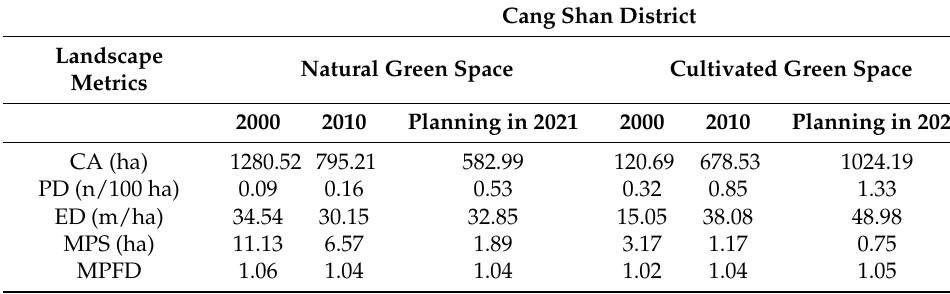
Table A1. The comparison of landscape metrics on class level of Cang Shan district.